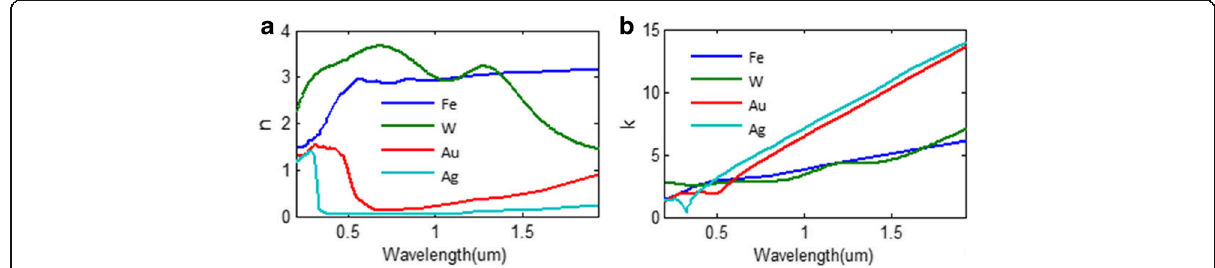
Fig. 13 Comparing of the a real part of refractive index and b the imaginary part of refractive index of commonly used metals